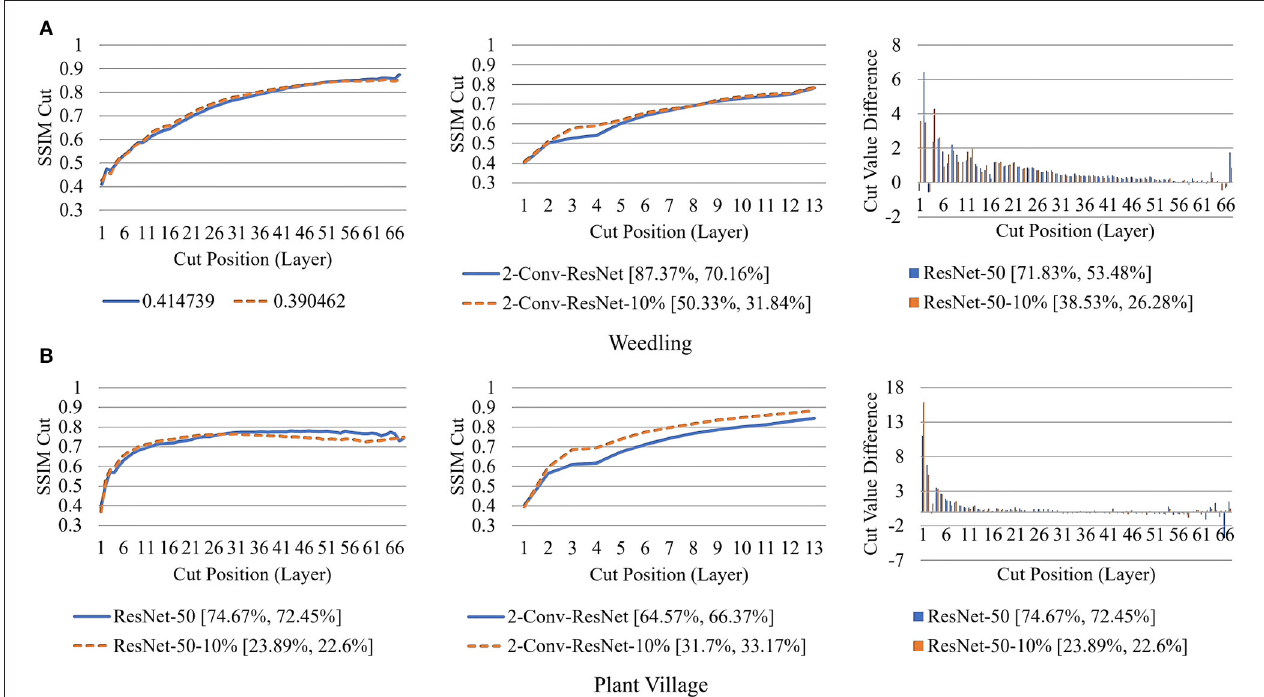
FIGURE 12 | Comparison of the Cut Position (Layer) VS SSIM cut curve for the ResNet-50, ResNet-50-10 % , 2-Conv-ResNet, and 2-Conv-ResNet-10 % models, and Cut Value Difference for the ResNet-50, ResNet-50-10 % for different datasets at Epoch (1). The value in the legend of the chart indicate the training and testing accuracy of the model. (A) Weedling. (B) Plant